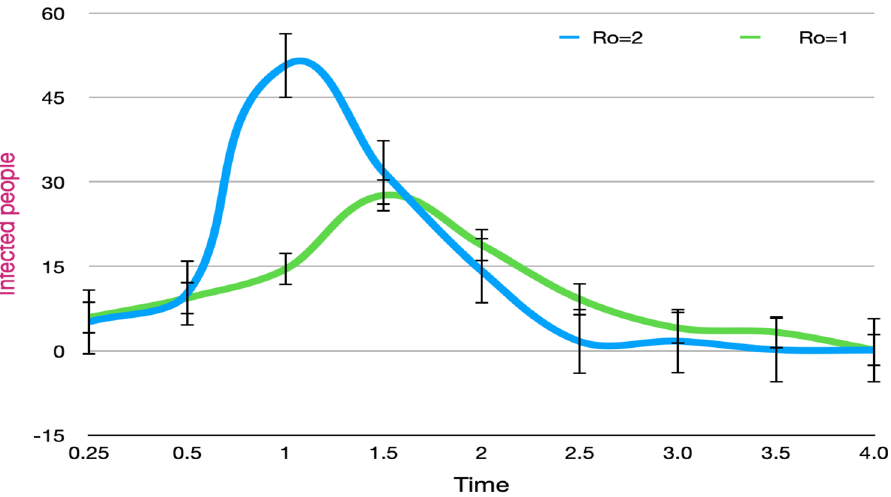
Figure 12. Used Hamiltonian being simulated using the IBM quantum experience platform, demonstrating the phenomena of curve flattening. A 2-D graph depicting the shift of the peak along X-axis when R 0 is